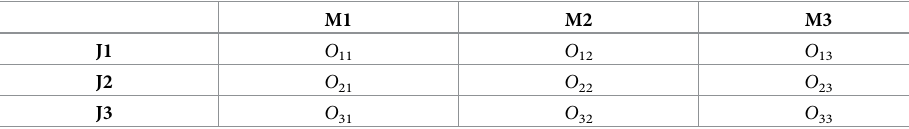
Table 1. A problem instance with three products and three